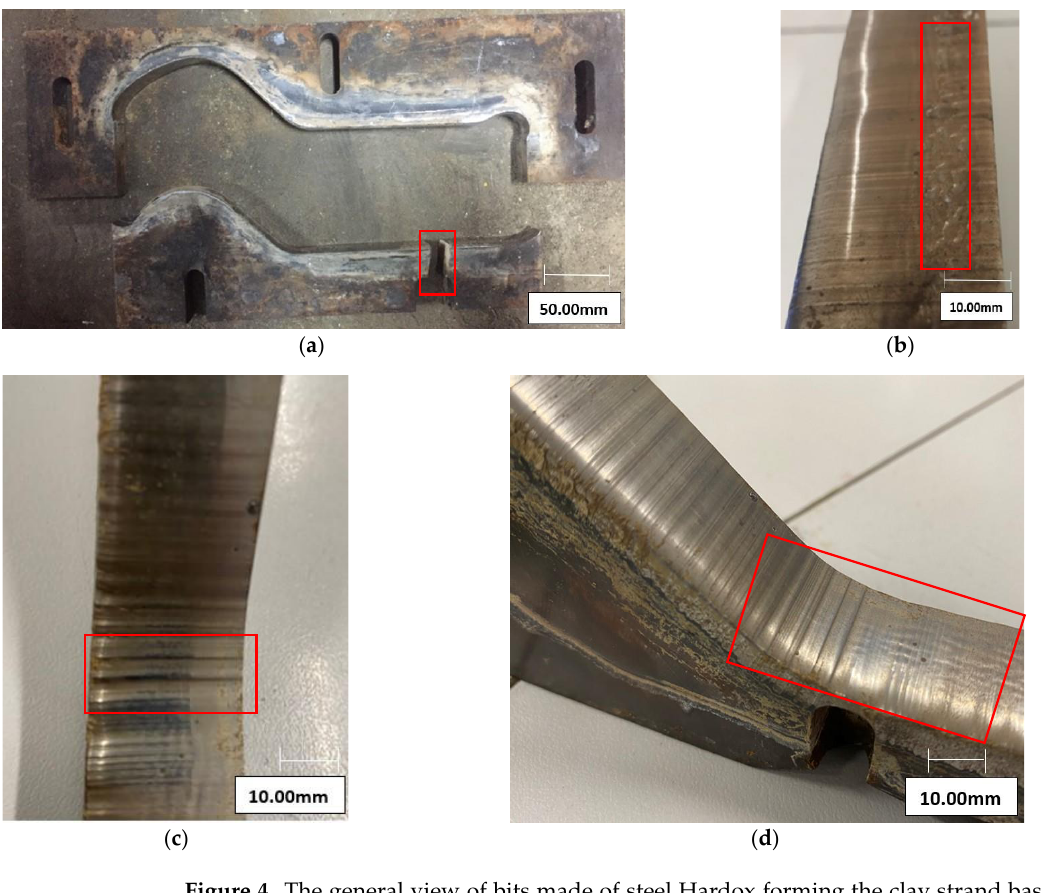
Figure 4. The general view of bits made of steel Hardox forming the clay strand based on visual inspection: ( a ) cracks, ( b ) traces of impressions, ( c ) longitudinal scratches, ( d ) scratches and cavities in the transverse direction.